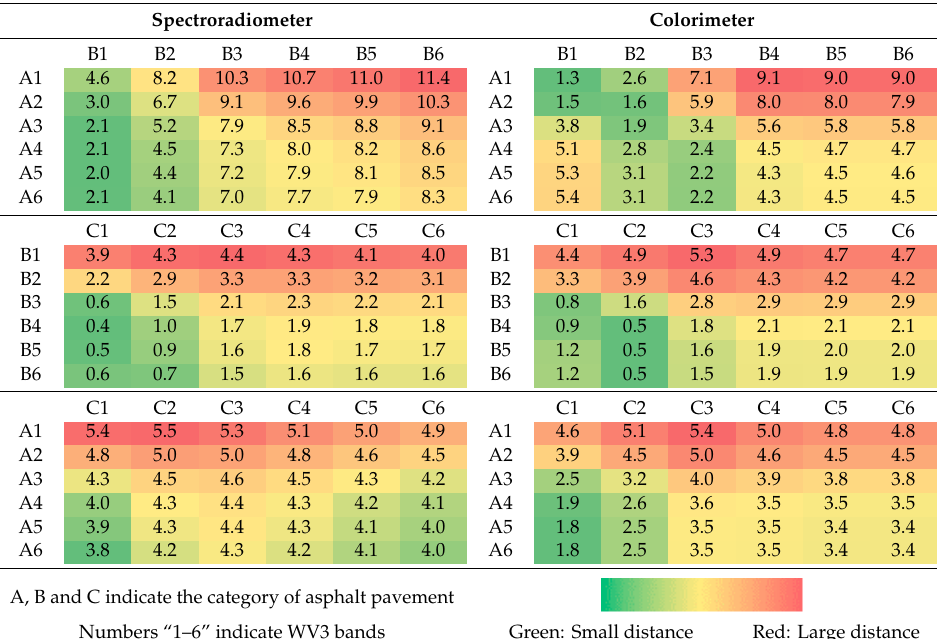
Table 7. Mahalanobis distance of WV3 bands in the visible spectrum for spectroradiometer (left) and colorimeter (right).